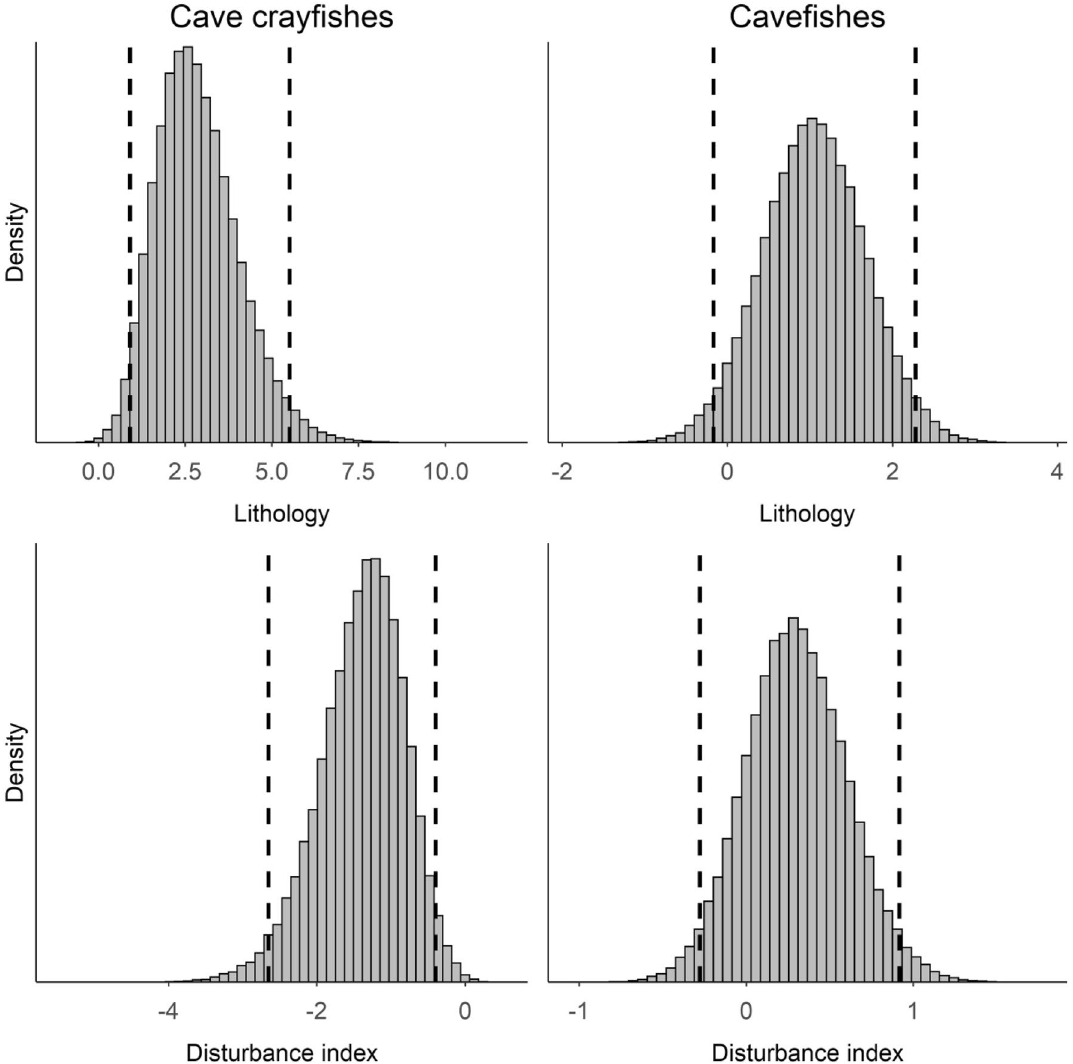
Figure 3. Posterior distributions for the coefficients from our model used to predict occurrence probability of cavefishes and cave crayfishes. The values on the x-axis represent parameter estimates for each covariate. The dotted lines are 95% highest density intervals. The categorical variable lithology was set to